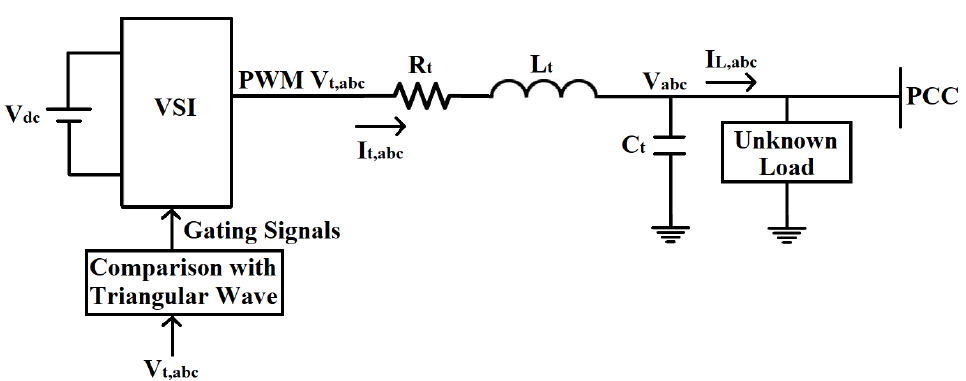
Figure 1. Voltage source inverter (VSI) with the output